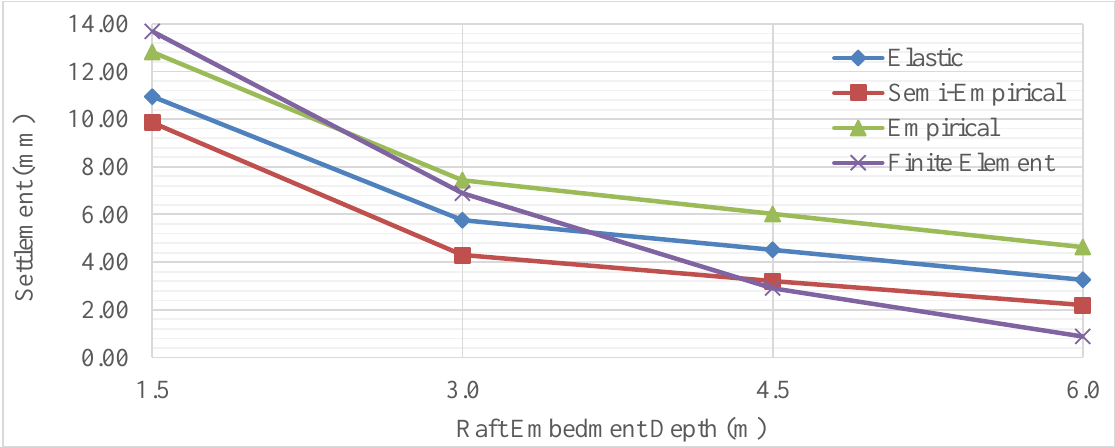
Fig. 4. Settlement versus embedment depth for 50 kN/m 2 applied pressure.